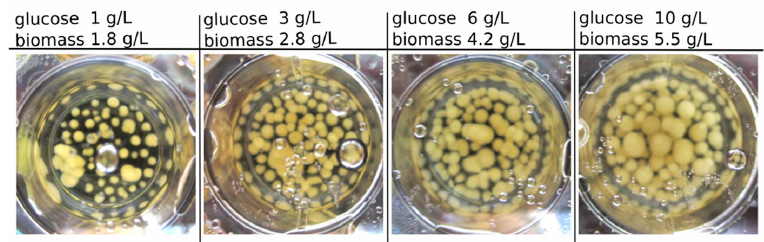
Figure 1. Biomass growth in a 3 mL culture (in 12-well plates) with different initial glucose concentration (1, 3, 6 and 10 g/L) and the final dry biomass concentration at the same initial nitrogen concentration of 0.89 g N / L after 14 days of